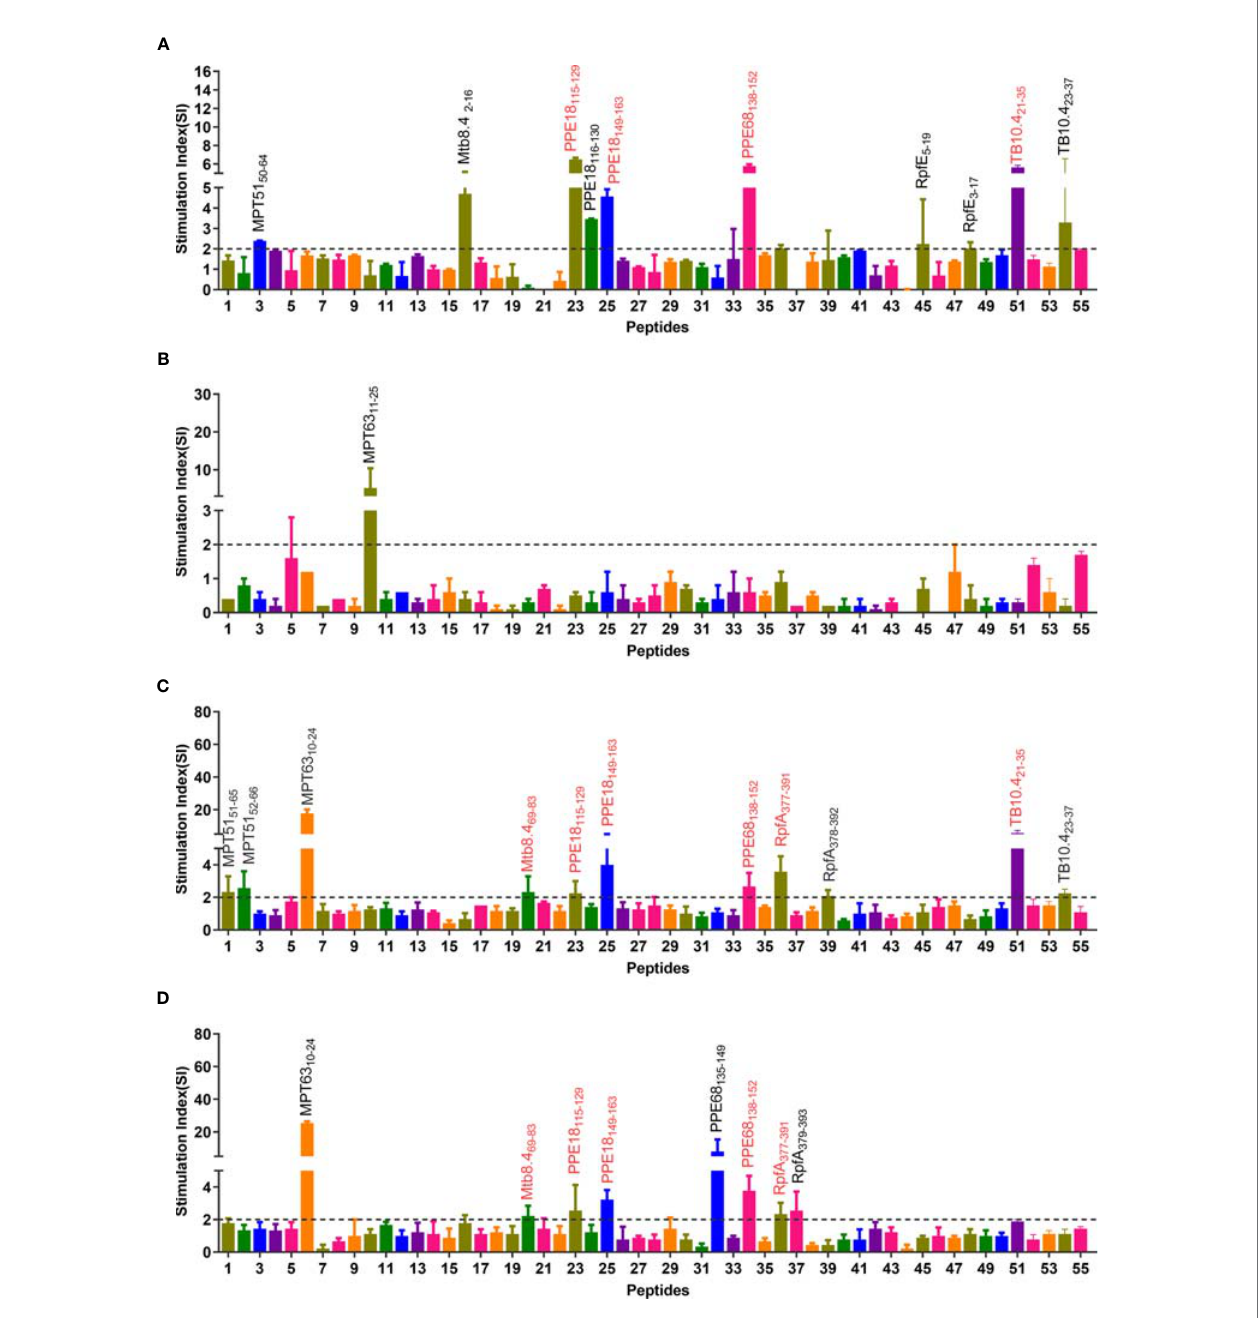
FIGURE 2 | Immunodominant peptides screening via four independent ELISPOT experiments. Splenocytes obtained from humanized mice immunized with inactivated M. tuberculosis in CFA adjuvant (A) , lysate of M. tuberculosis in PBS (B) , lysate of M. tuberculosis in CFA adjuvant (C) , and lysate of M. tuberculosis in IFA adjuvant (D) were stimulated with MP3RT. The SFCs were analyzed by a CTL-S5 Versa ELISPOT Reader. The SI value of 55 peptides was shown as the ratio of SFCs in peptide stimulated cells and medium-stimulated cells. The detailed information of 55 peptides can be found in Table S1 . SI >2 was considered positive and labeled in the fi gure. The immunodominant peptides included in the MP3RT vaccine were marked using a red text